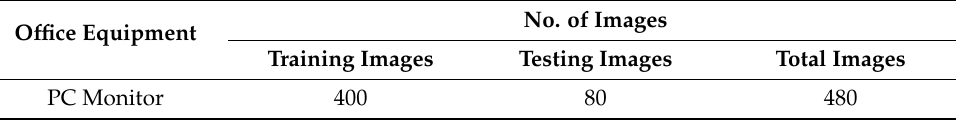
Table 1. The training and testing images for the equipment detection model.